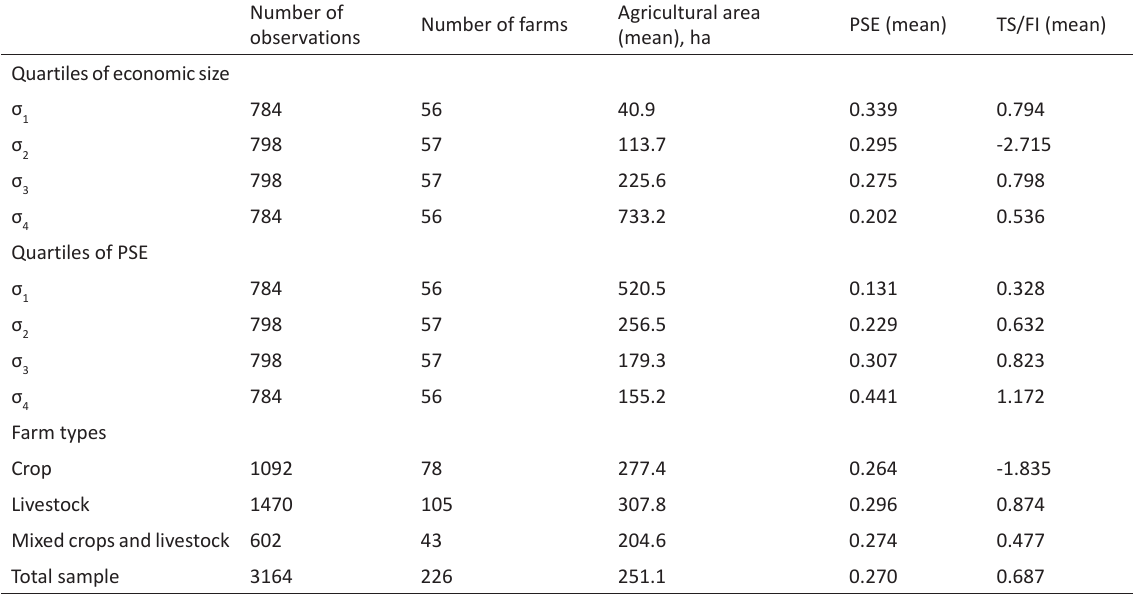
Table 1. The share of total subsidies in FI (full sample including observations with negative MI) Number of